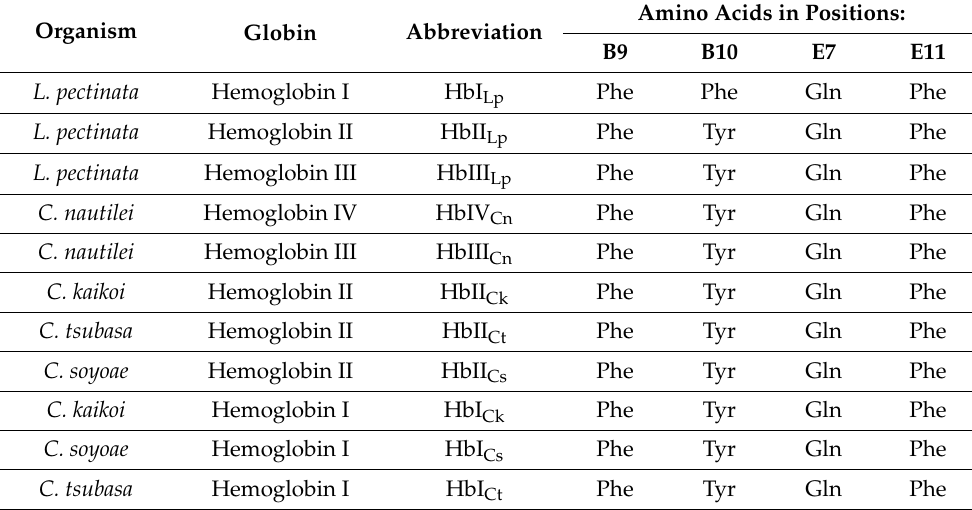
Table 1. Amino acids in positions conserved in organism living in sulfide-rich environments. Organism Globin